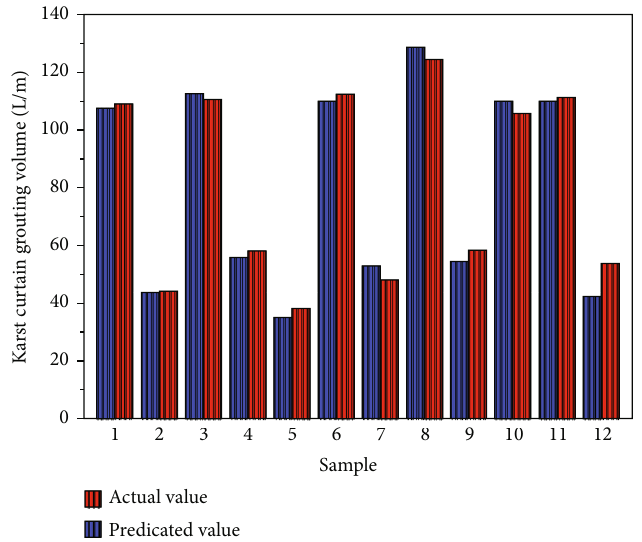
Figure 9: The comparison between the actual value and the predicted value of the KCGV.